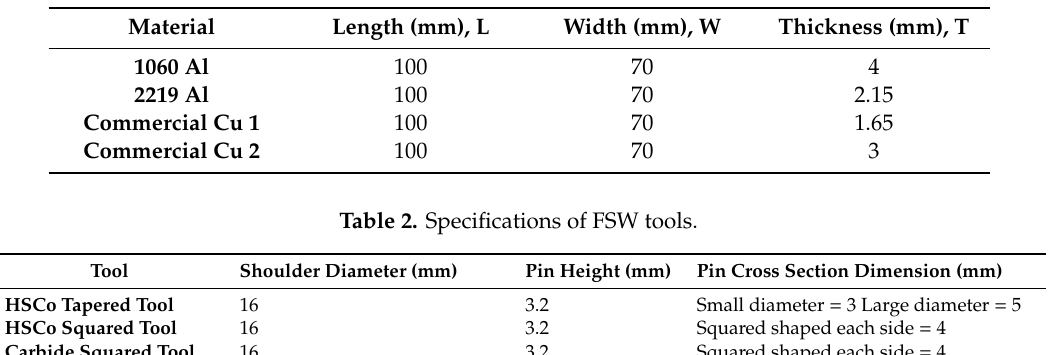
Table 3. Mechanical properties of base